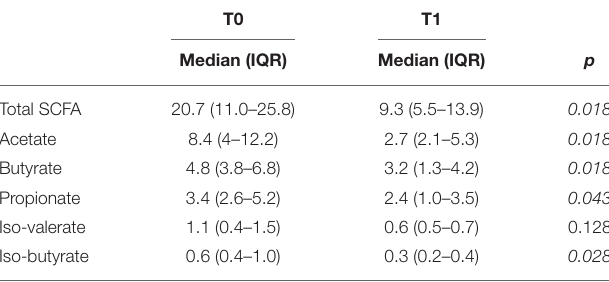
TABLE 2 | Fecal SCFA concentrations (mg/g dry feces) before (T0) and after 1 month (T1) of the KD.